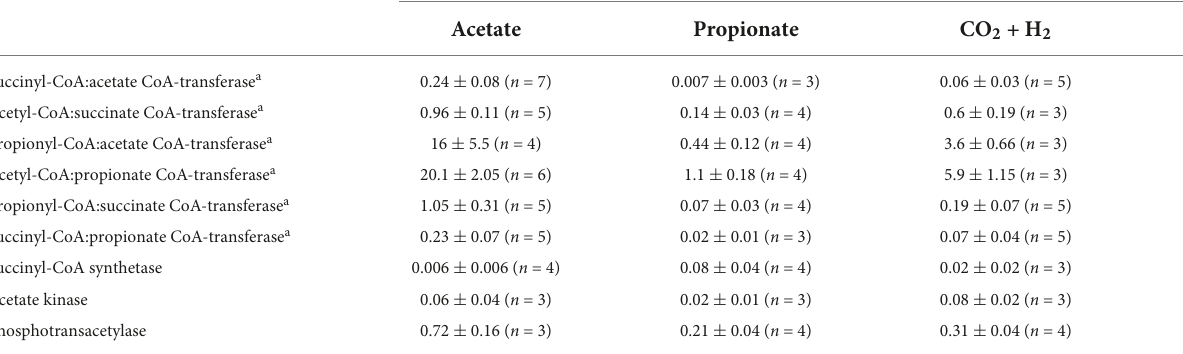
TABLE 1 Enzyme activity in extracts of Desulfurella acetivorans cells grown under autotrophic or heterotrophic conditions in the presence of acetate or propionate.